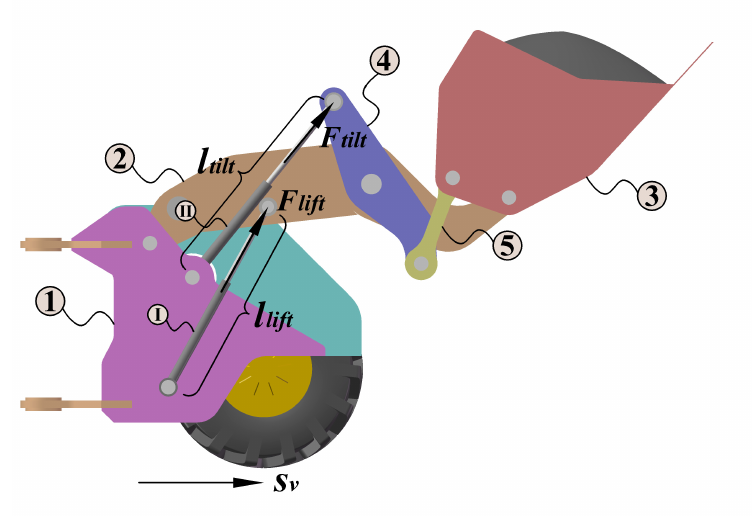
Figure 1. Loader working mechanism system